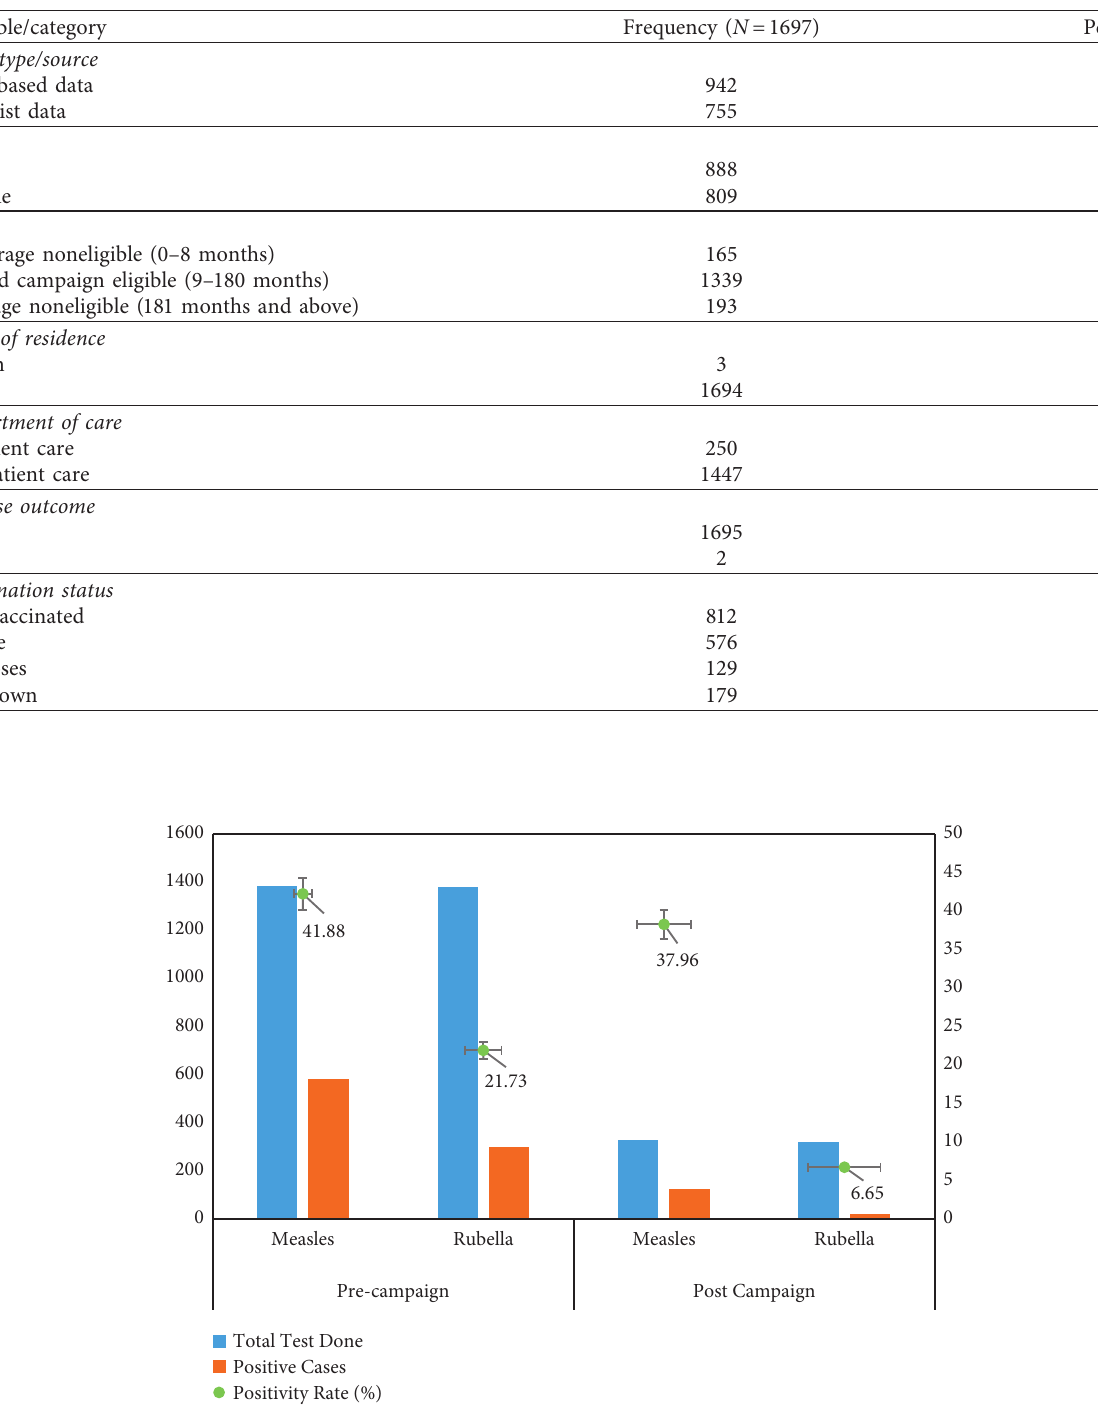
Table 1: Background characteristics of the study